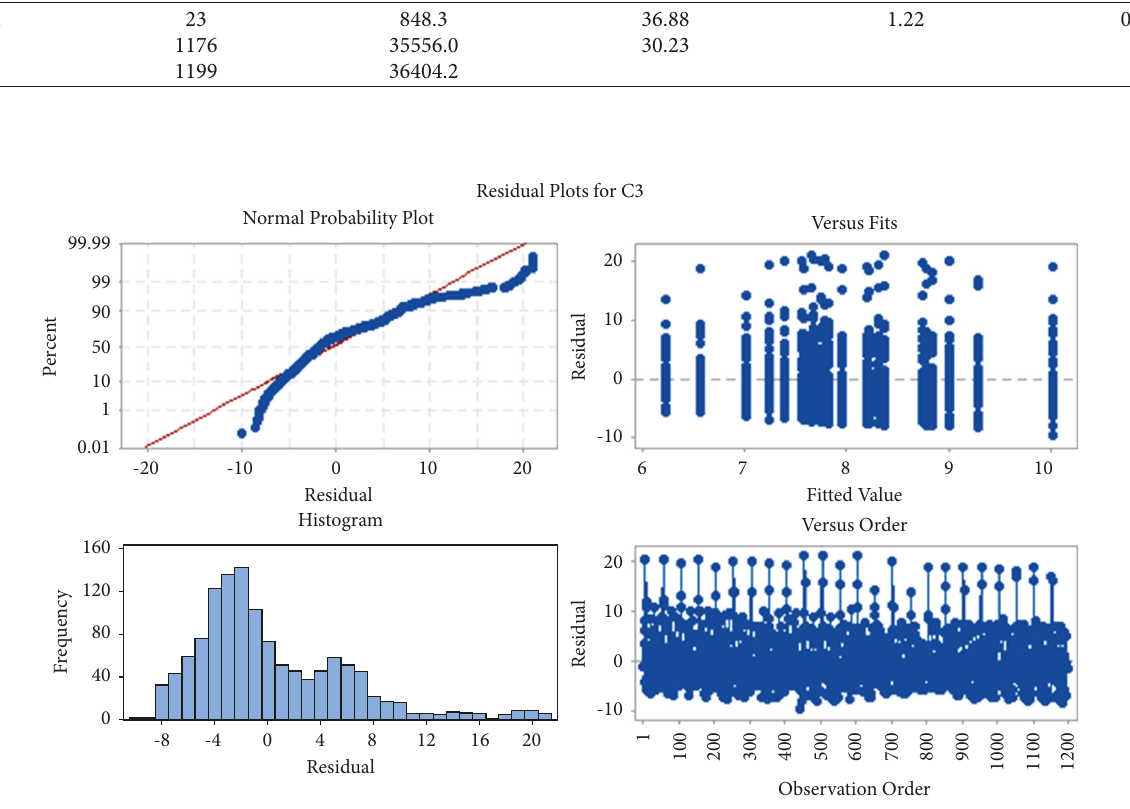
Figure 5: Review of analysis of variance results.